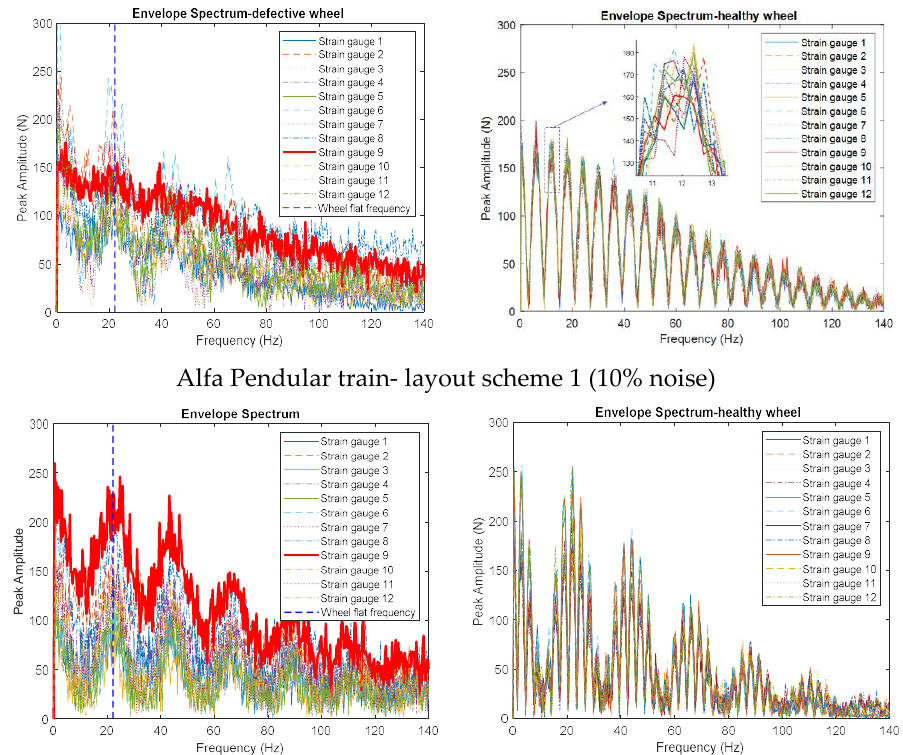
Figure 12. Envelope spectrum analysis for the 12 strain gauges (layout scheme 1) with different noise intensities and considering a defective and healthy wheel of the Alfa Pendular train and the freight wagon.